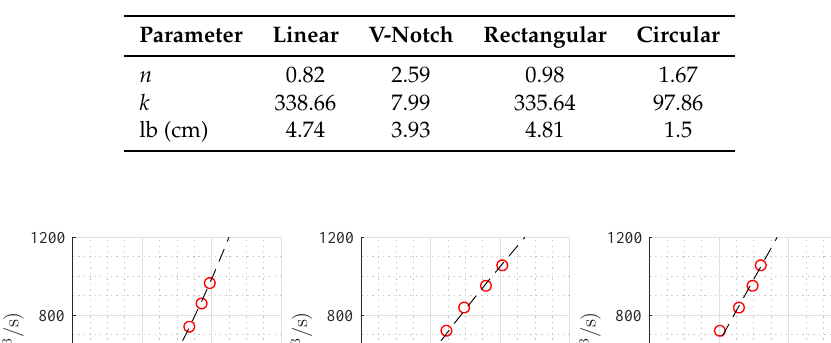
Table 2. Weirs’ constant